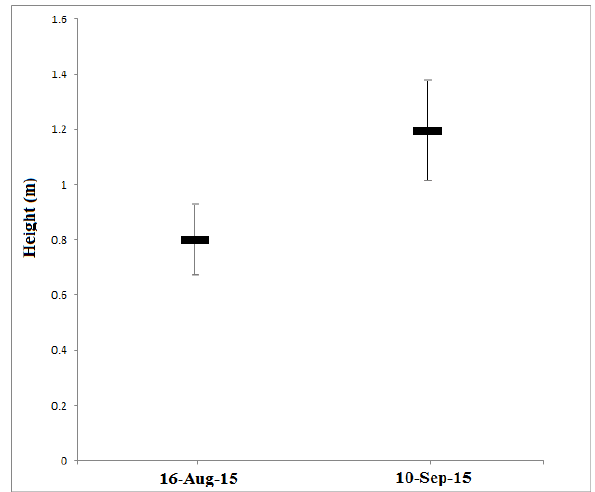
Figure 3. The range of plant heights observed from the 17 farmers’ fields during the both